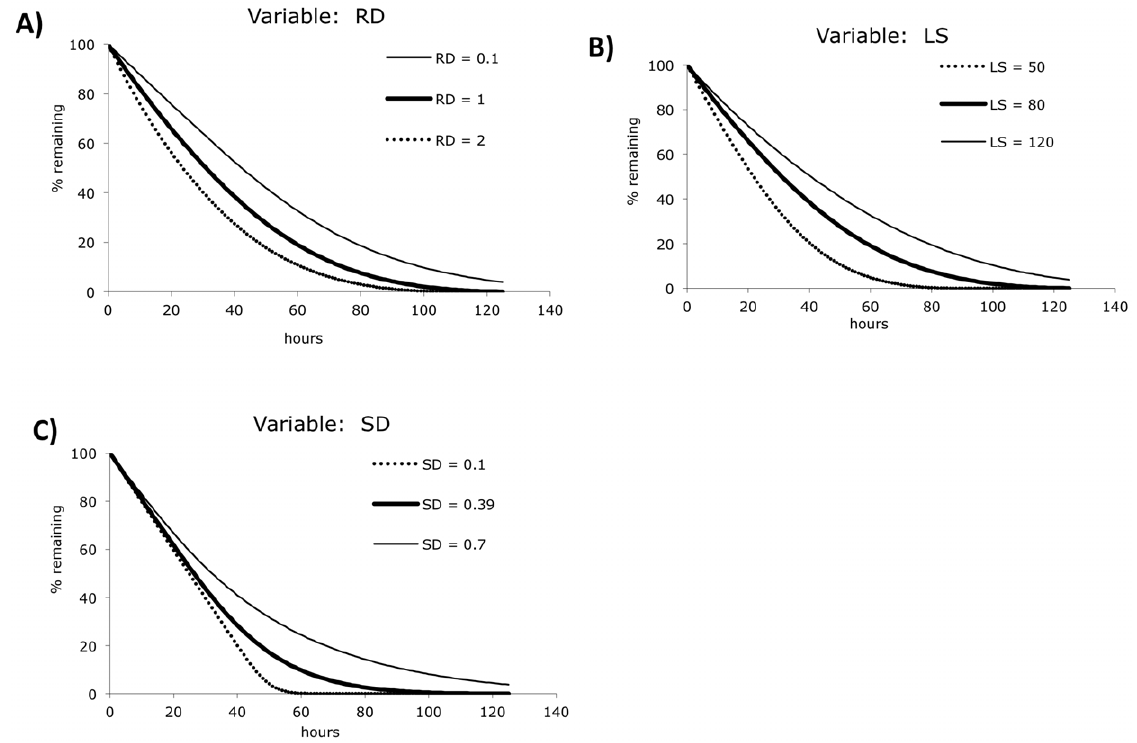
Figure 3. Effect of parameter value changes on the consumption curve. A 500 hour equilibration phase was used. A) Consumption at LS=80, SD=0.44. B) Consumption at RD=1.0, SD=0.44. C) Consumption at RD=0.1, LS=50. Equilibration metric values (e) are greater than 0.95 for all of the parameter sets shown (data not shown).